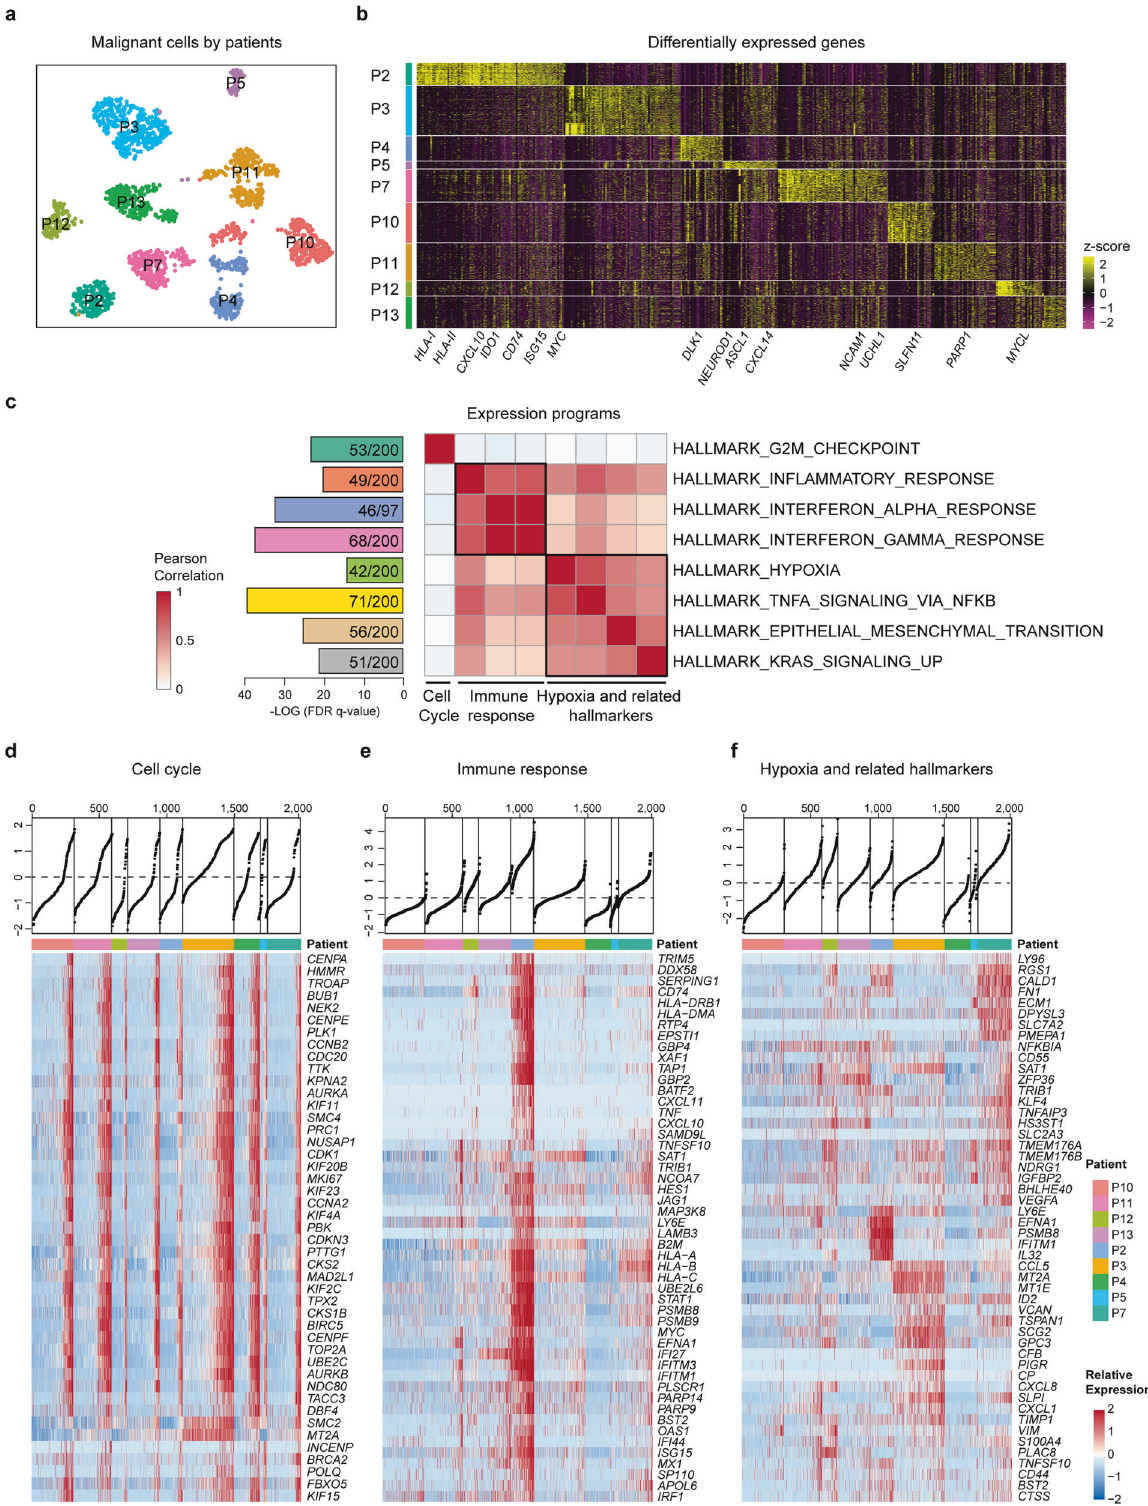
tumor cell heterogeneity in SCLC (i.e., the expression of diverse transcriptional programs), which has great potential for better understanding the SCLC biology, optimizing current treatment, and developing new therapeutic strategies for